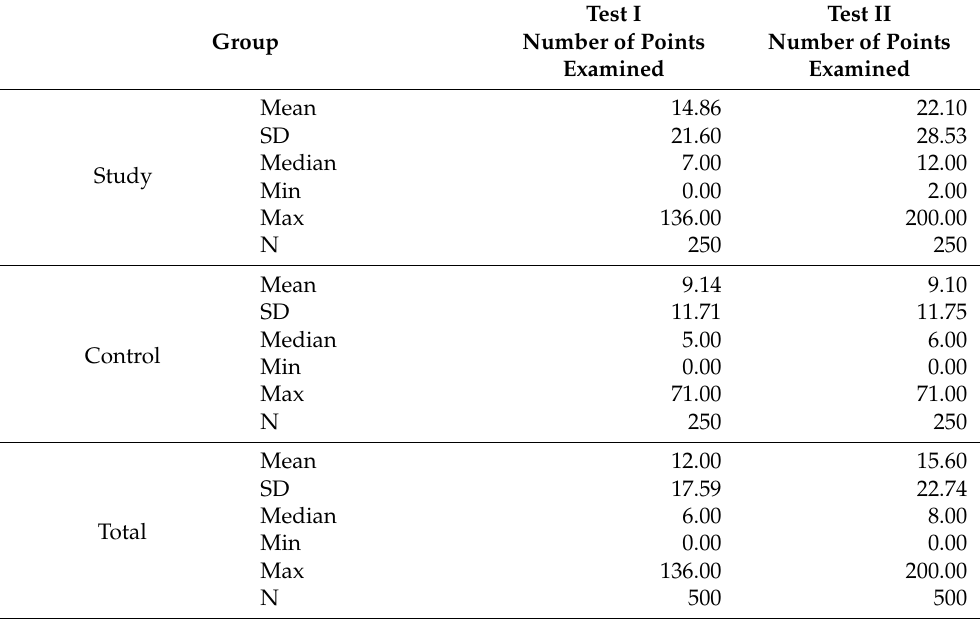
Table 8. Number of points marked in the tactile test—Test I and II.